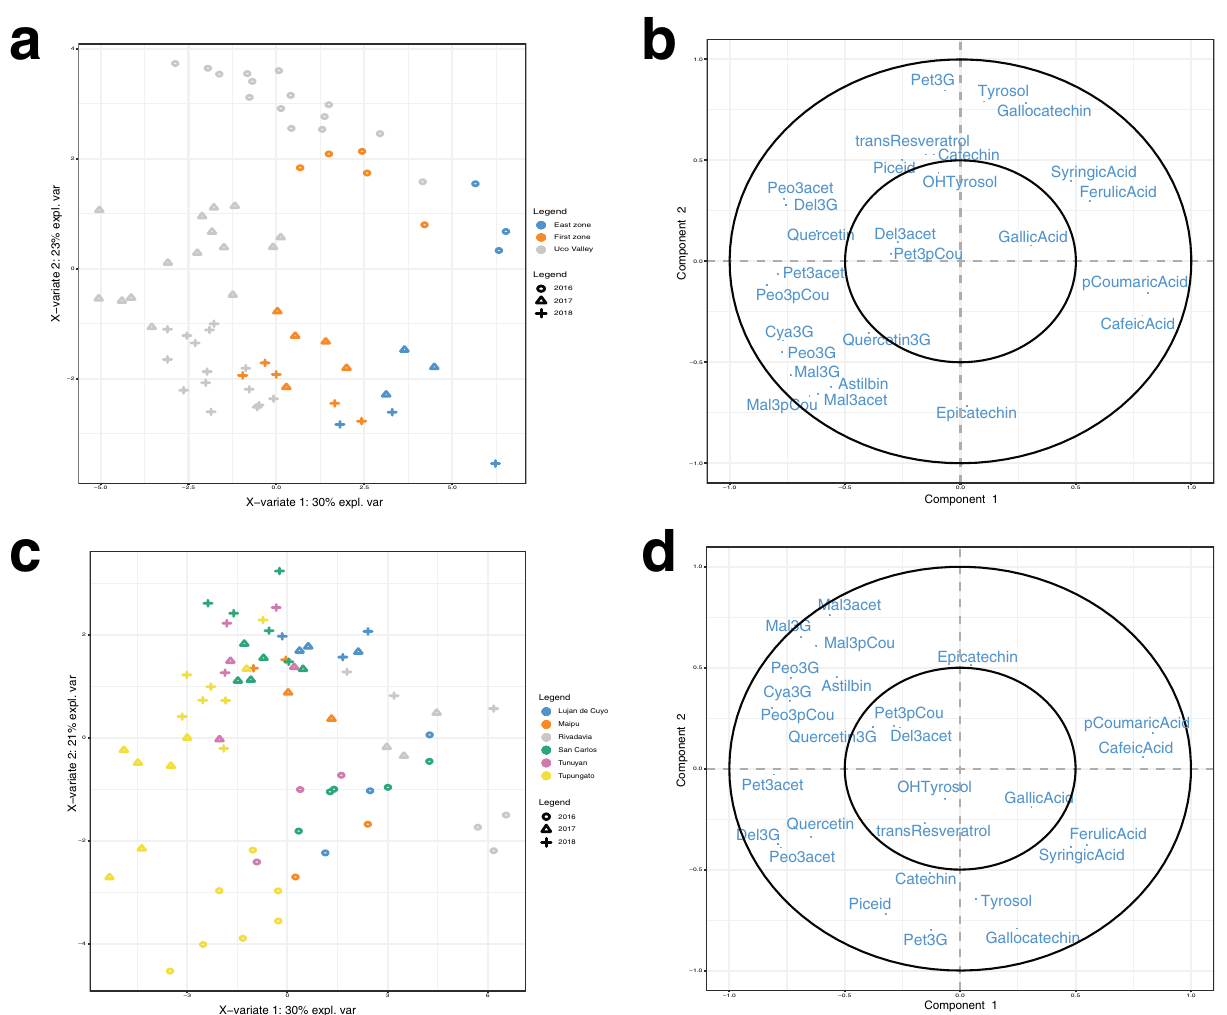
Figure 3. Supervised analysis with PLS-DA sample plot by ( a and b ) for Zones, and ( c and d ) for Departments. For comparative purposes all regions were classified as GIs. The figure was generated using Adobe Illustrator, version 22.1.0 (https ://www.adobe .com/produ cts/illus trato r.html) and R-package